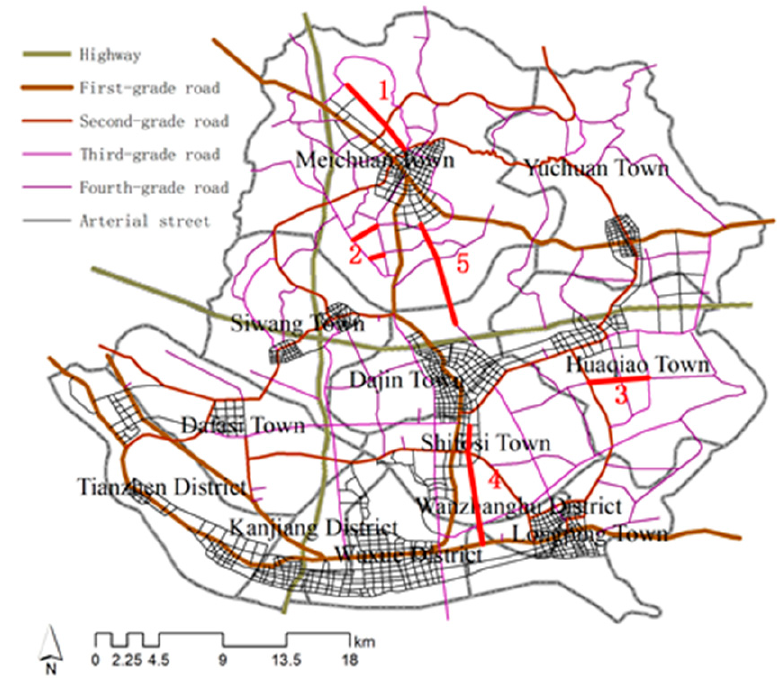
Figure 17. Add new